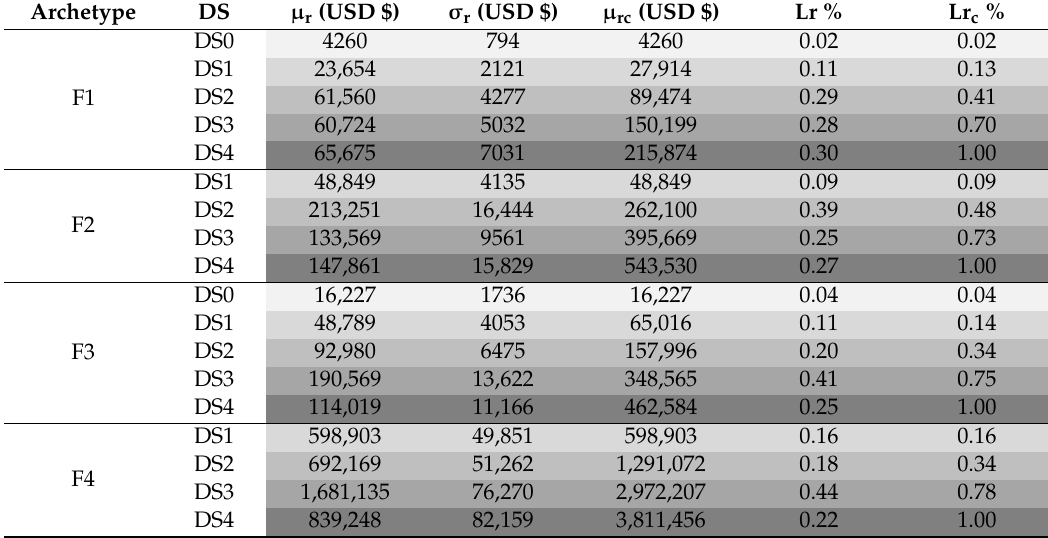
Table 5. Damage states replacement cost data for each building archetype ( µ r : mean DS